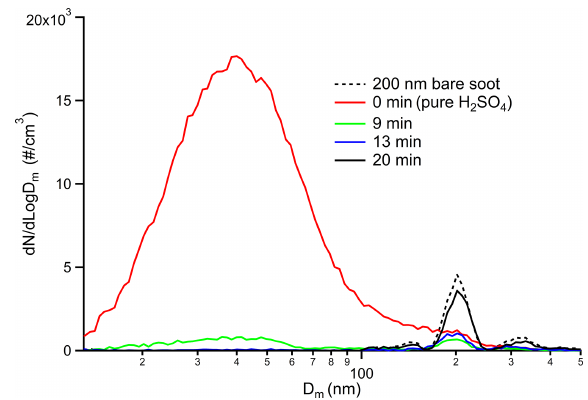
Figure A1. The raw size distribution of the particles coming out of the coating apparatus in 20min after 200nm mCASTblack soot aerosol sample flow is connected to the coating apparatus. The red line denotes the initial state of H 2 SO 4 aerosol, where only nucleation-mode H 2 SO 4 exists in the coating system without soot particles. The dashed black line indicates bare 200nm black soot particles. The green line presents the particle size distribution 9min later when the soot particles were fed into the coating apparatus. The blue line shows the particle size distribution 13min later. The black line stands for the stable mixing state of soot particles with H 2 SO 4 .